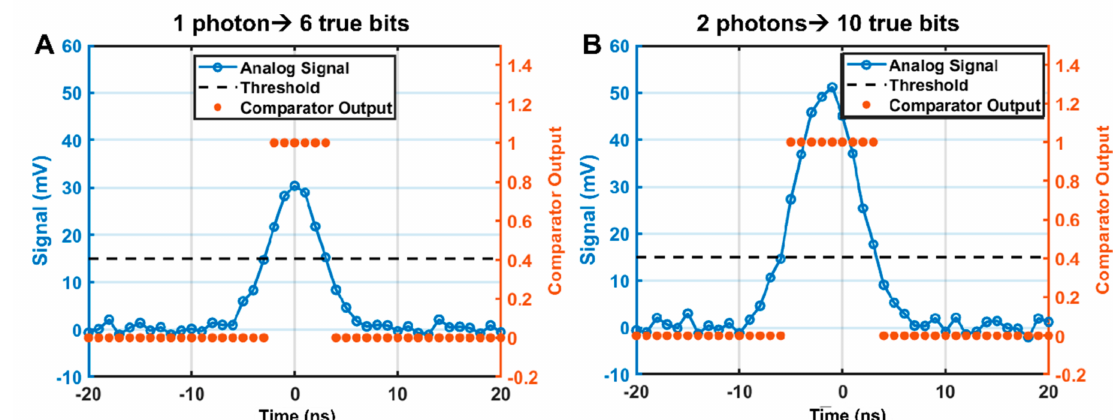
Figure 6. One and two-photon simulated analog to digital conversion at 1.00787 GHz exhibiting the origin of the comparator bias and detected pulse width bias. ( A ) In the single photon case the comparator records six 1’s above the threshold for a single photon. Each 1 contributes to the peak amplitude of the cross-correlation, which leads to a positive bias if uncorrected. ( B ) Analog detector signal from two-photon detection, with the photons arriving 3 ns apart. The comparator records 10 1’s above the threshold, which is less than twice the single-photon value, leading to a negative